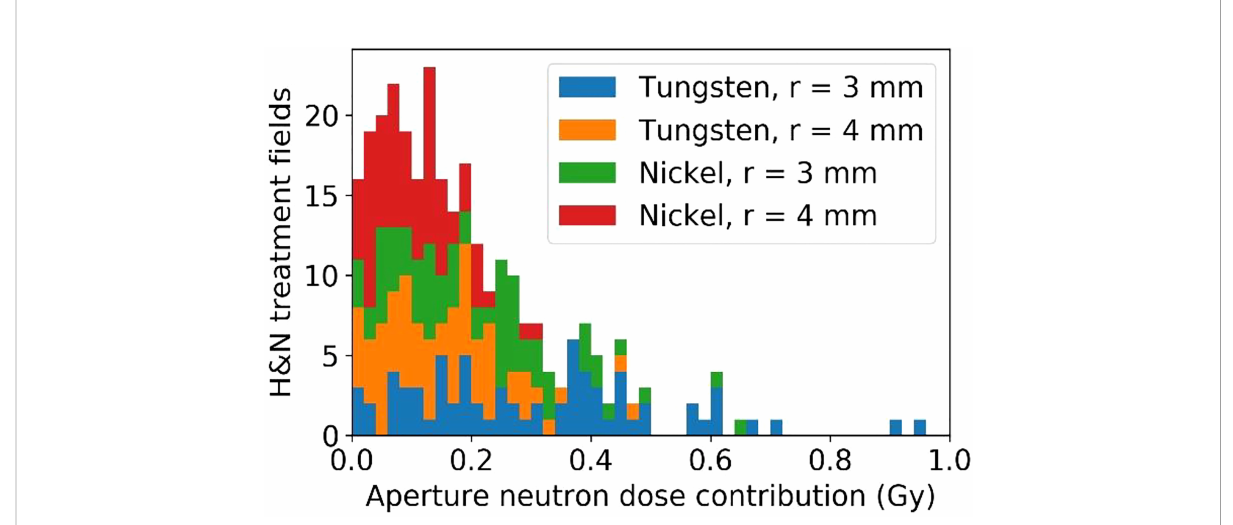
FIGURE 13 The estimated excess integral neutron dose as produced by the tungsten or nickel aperture in the SSA for 45 H&N treatment plans that were delivered